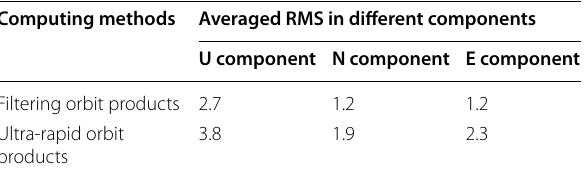
Table 4 Mean offset, STD, and RMS of the SLR residuals for the filtering orbit products (unit: cm)